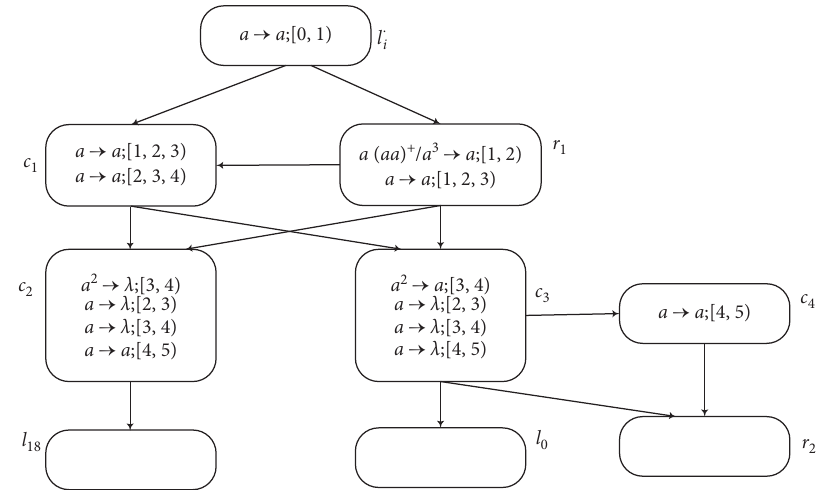
Figure 12: Module SUB-ADD-2: simulating the consecutive SUB instruction l